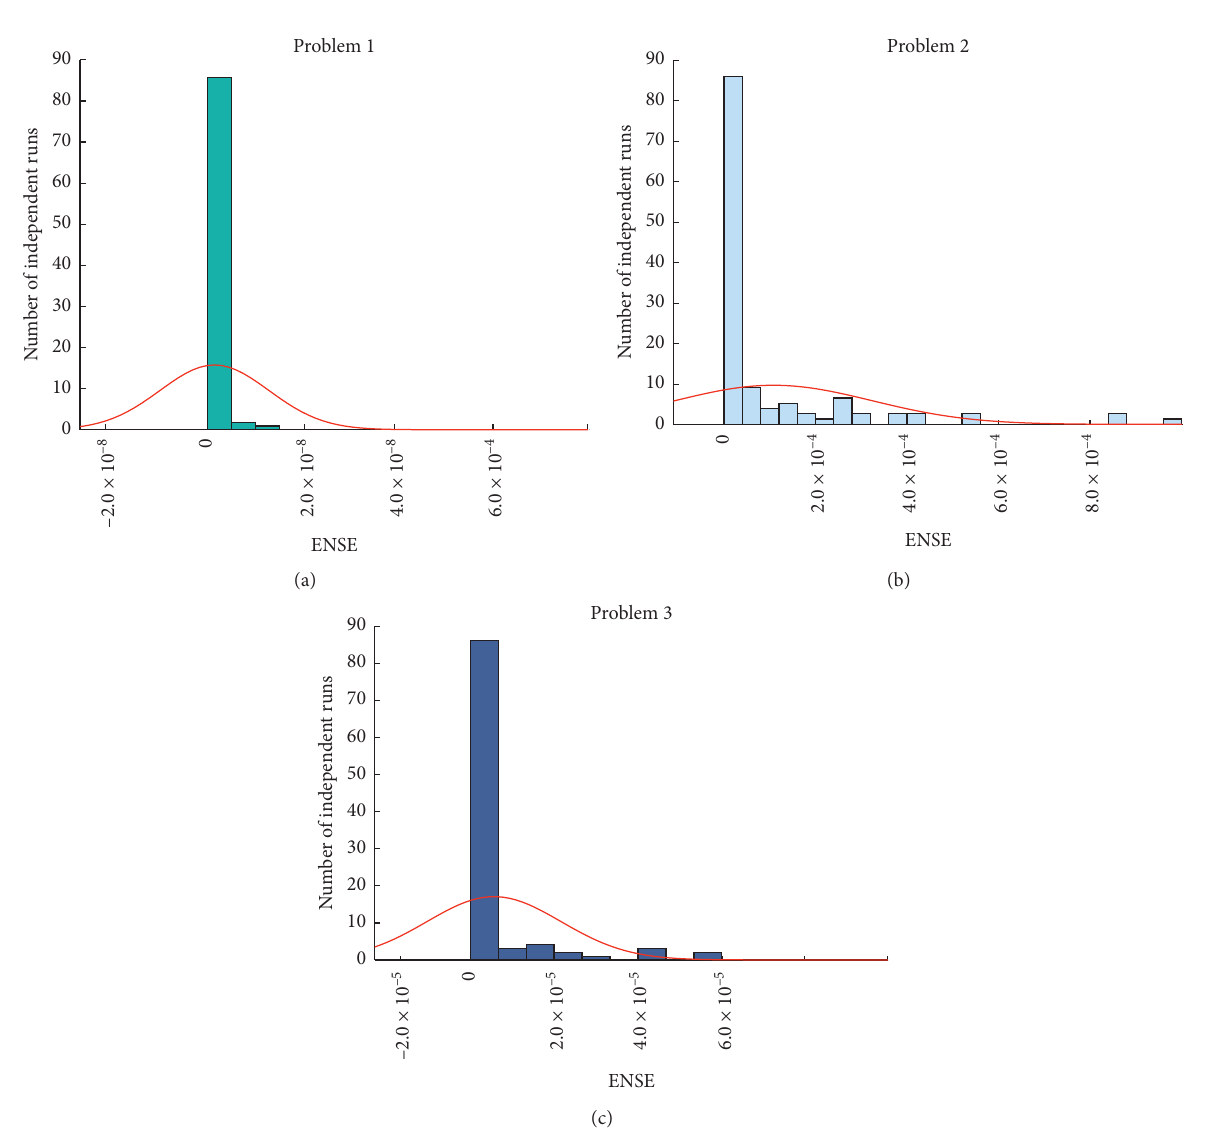
Figure 10: Normal probability plots of ENSE obtained during 100 experiments for Problem 1–3.